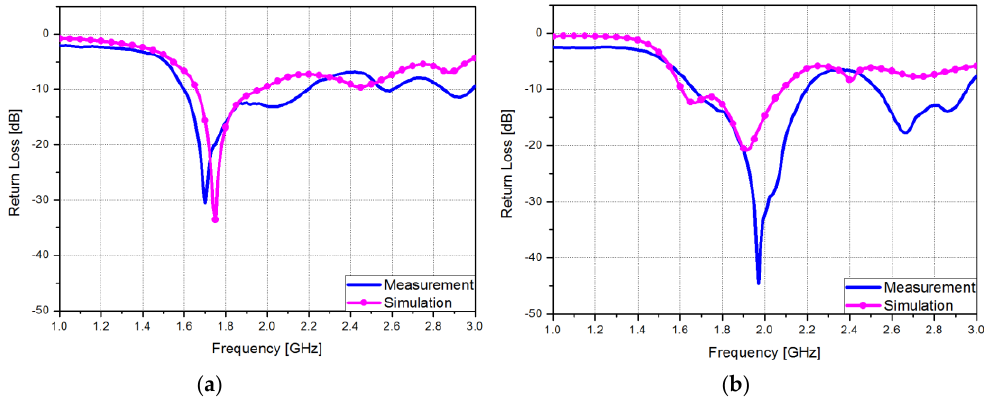
Figure 7. Simulated and measured return losses of the proposed antenna system when ( a ) first antenna is on and ( b ) second antenna is on.